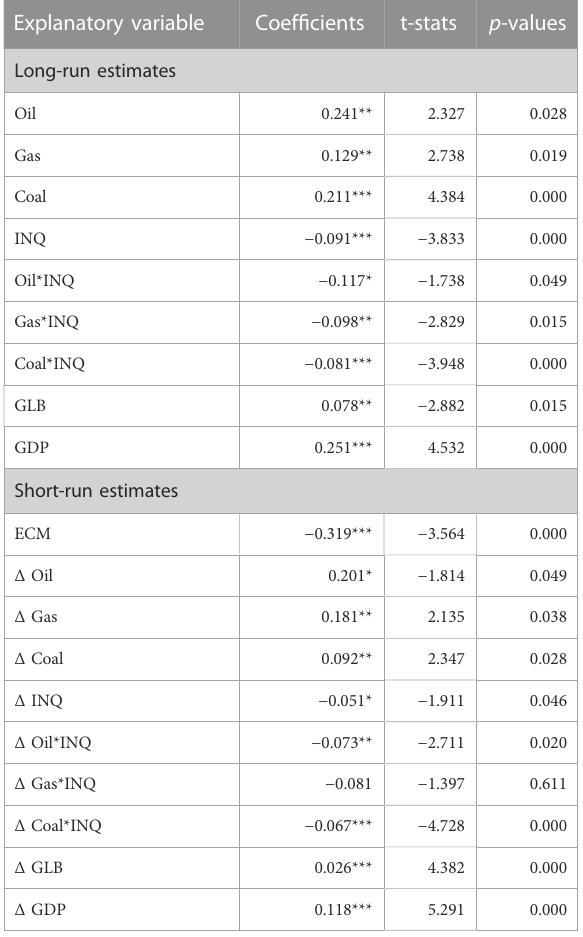
TABLE 4 CS-ARDL results.